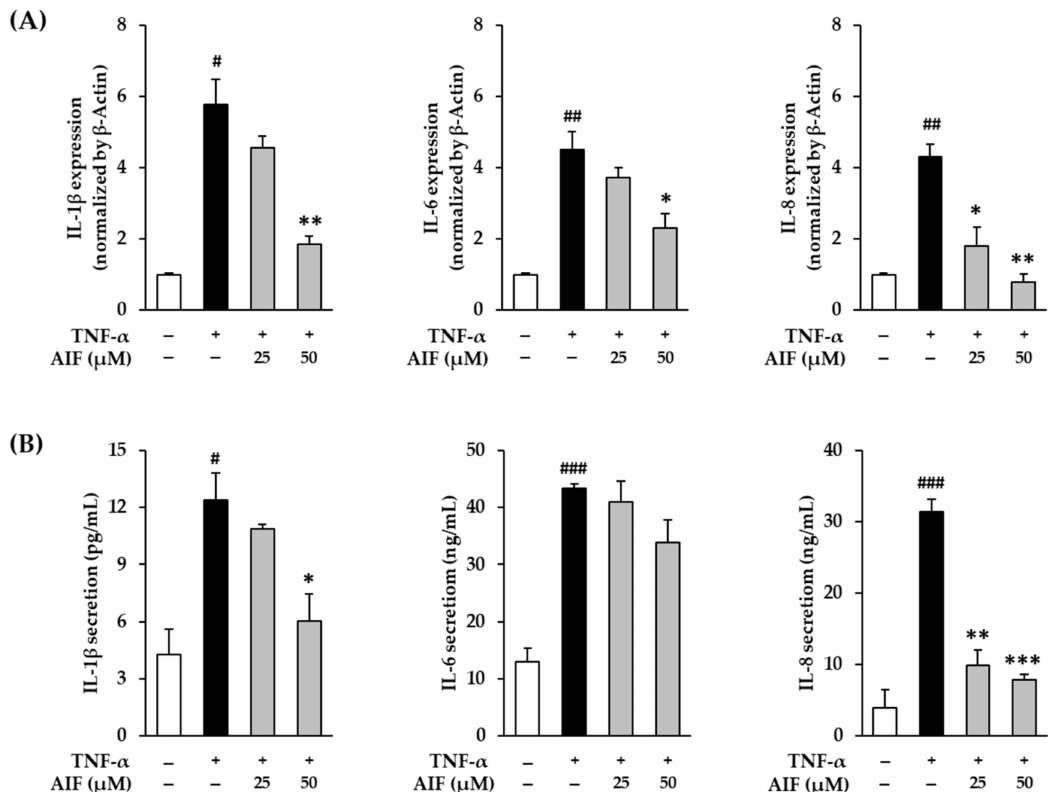
Figure 6. Inhibition of interleuk (IL)-1 β , IL-6, and IL-8 expression by alpinumisoflavone (AIF) in tumor necrosis factor- α (TNF- α )-treated human dermal fibroblasts (HDFs). ( A ) Relative mRNA expression levels of IL-1 β , IL-6, and IL-8. ( B ) Secretion of IL-1 β , IL-6, and IL-8. HDFs were challenged with 20 ng/mL TNF- α in the presence or absence of AIF (25 and 50 µ M) for 4 or 12 h. The protein expression was determined using qRT-PCR and ELISA. The data are presented as mean ± SEM of at least three independent experiments. # p < 0.05, ## p < 0.01 and ### p < 0.001 as compared to untreated cells. * p < 0.05, ** p < 0.01 and *** p < 0.001 as compared to TNF- α -treated